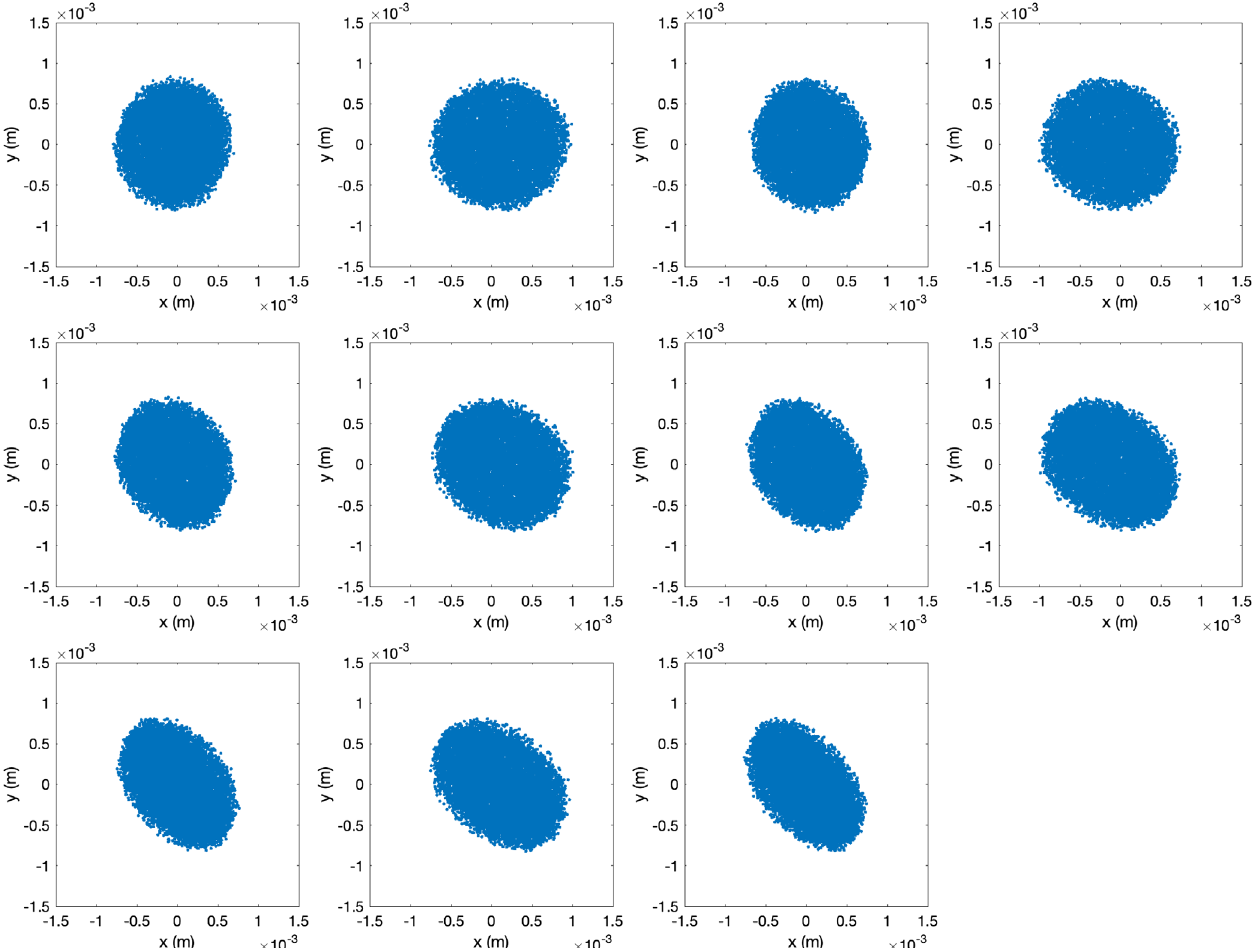
FIG. 14. The evolution of transverse profiles at the cooler over 11